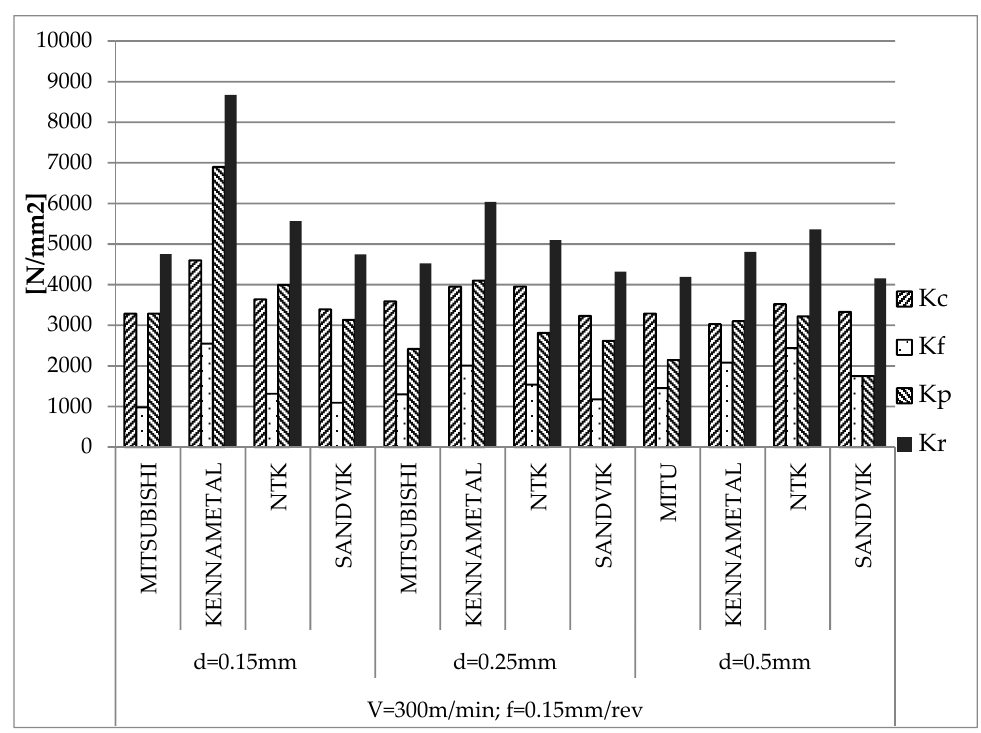
Figure 5. Initial specific machining force components and specific resultant forces in turning tests with different PCBN and JP2 grade cutting tools.